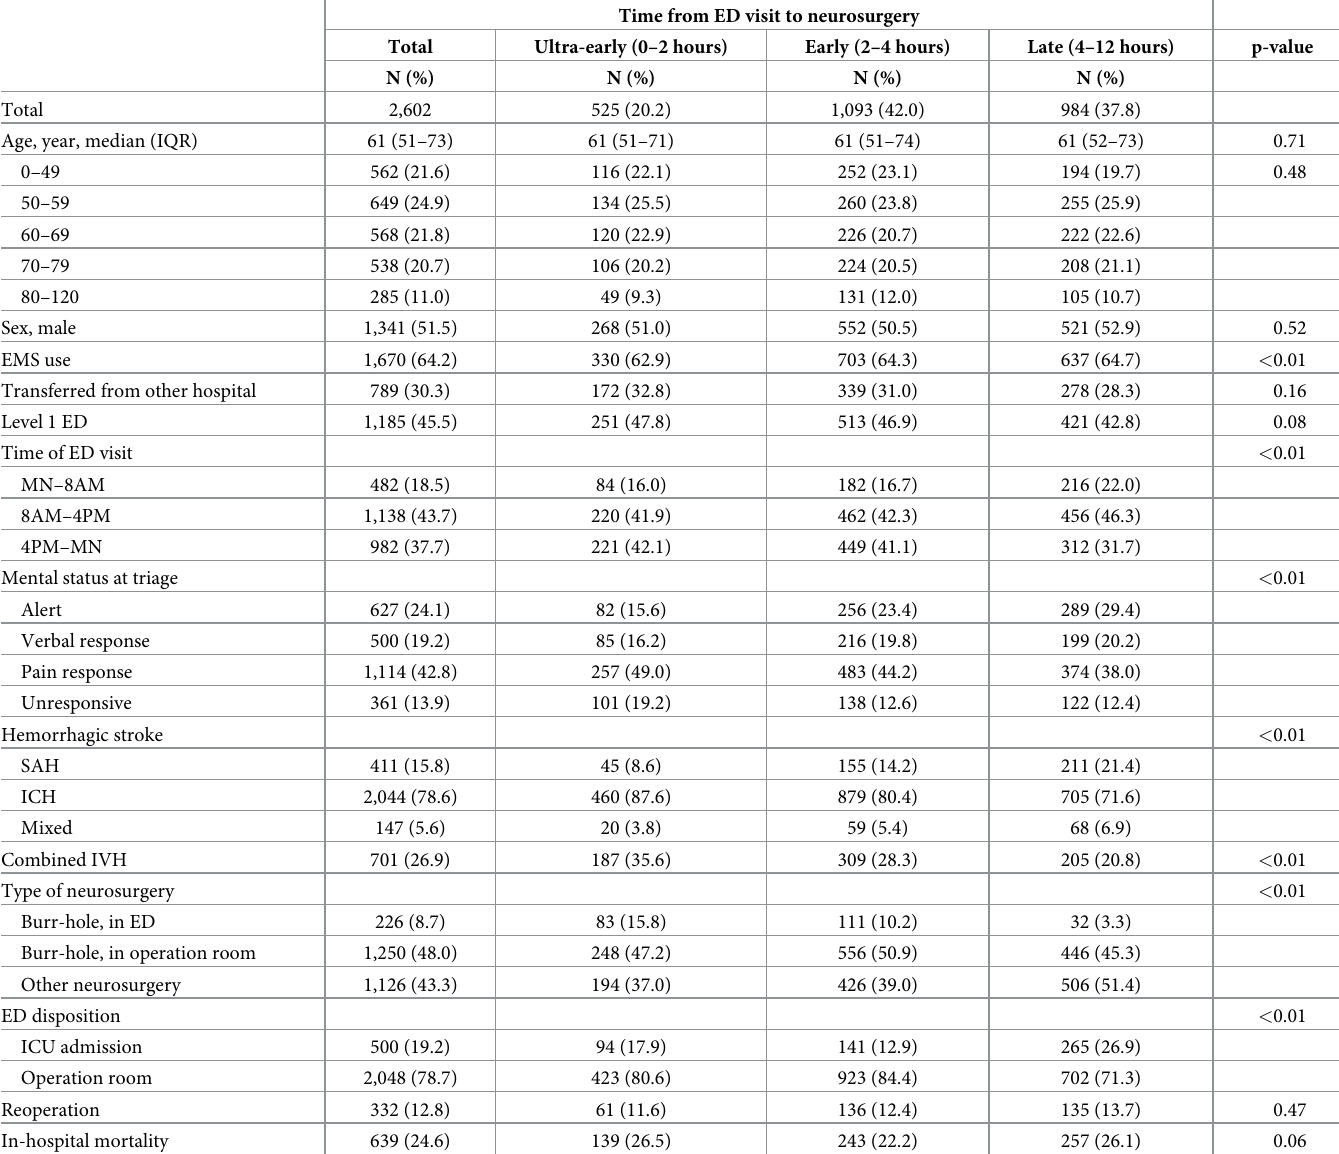
Table 1. Demographics of study population according to time from emergency department visit to emergency